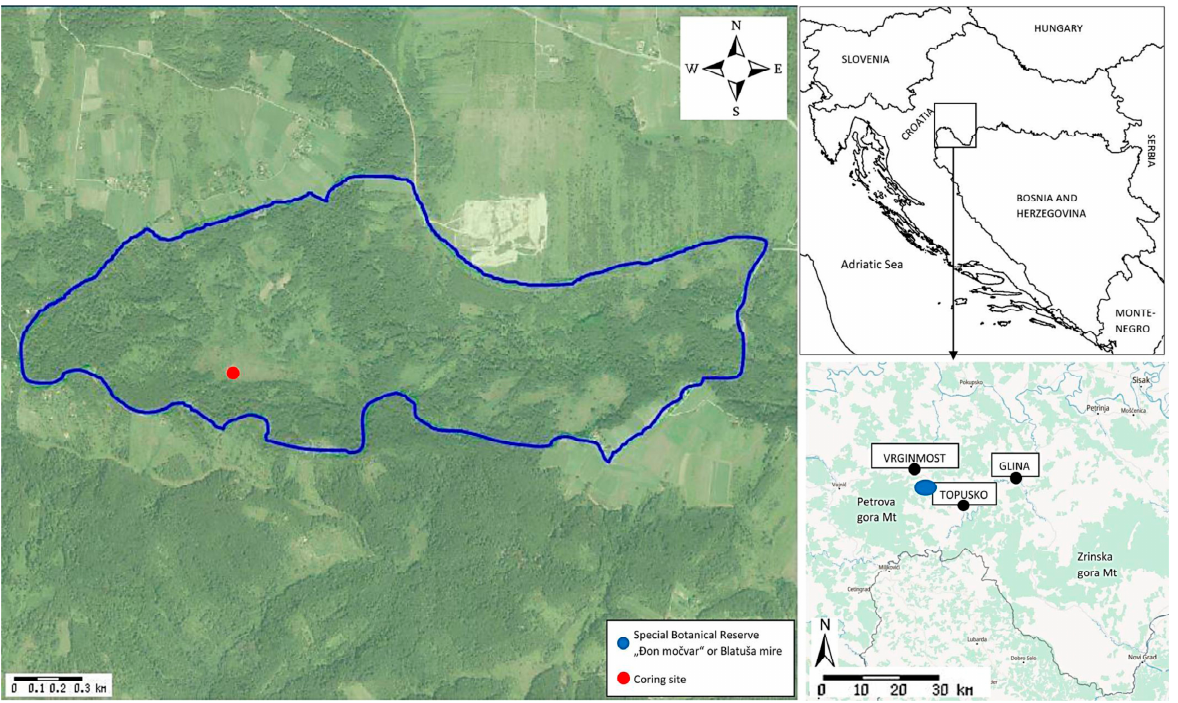
Figure 1. Map of the special botanical reserve “ Đ on Mo č var“ or Blatuša mire (blue marks), located in the Kordun geographical region, central Croatia (modified according to [40]).